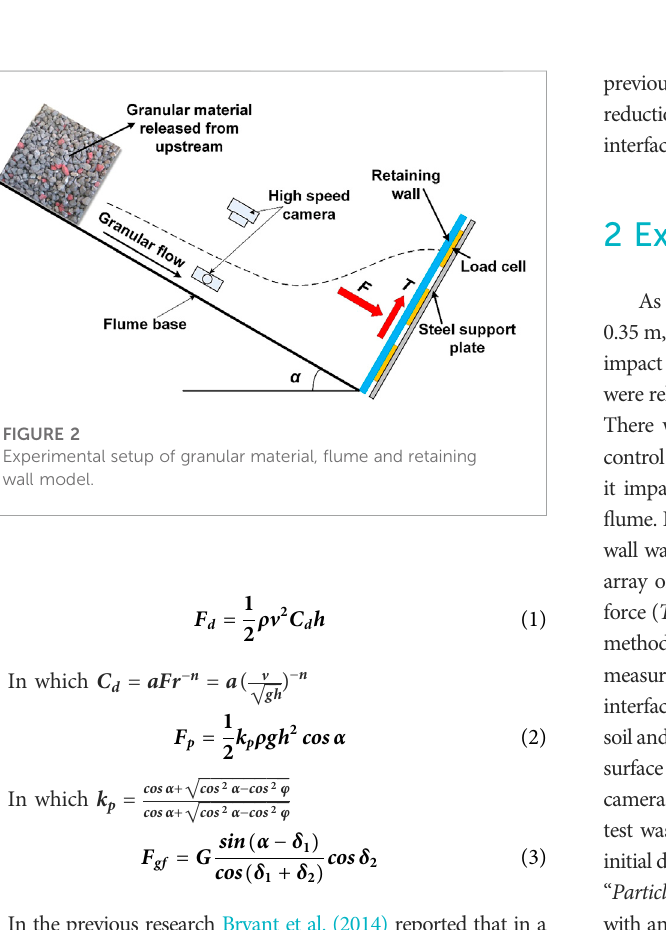
fl ume base and the retaining wall.